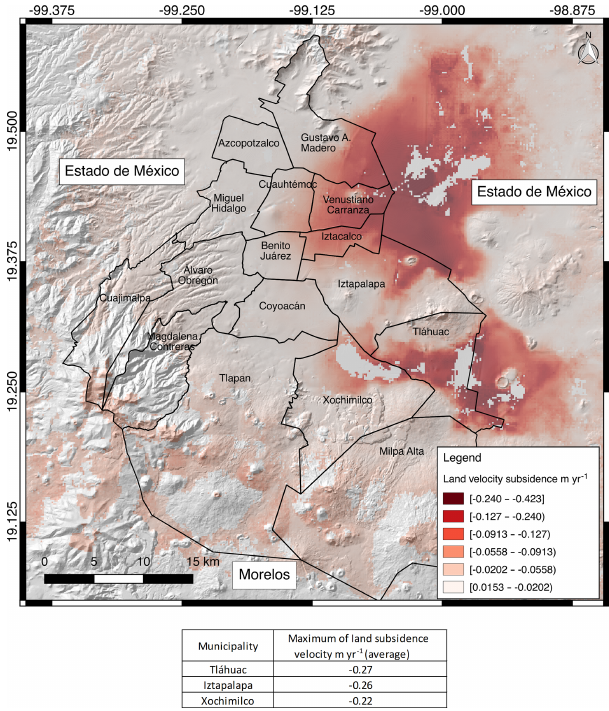
Figure 1. Velocity of Land Subsidence (LOS) of Mexico City (Oc- tober 2014–October 2017). The shaded topographic base layer is taken from Continuo de Elevaciones Mexicano 3.0. © Instituto Na- cional de Estadística Geografía e Informática